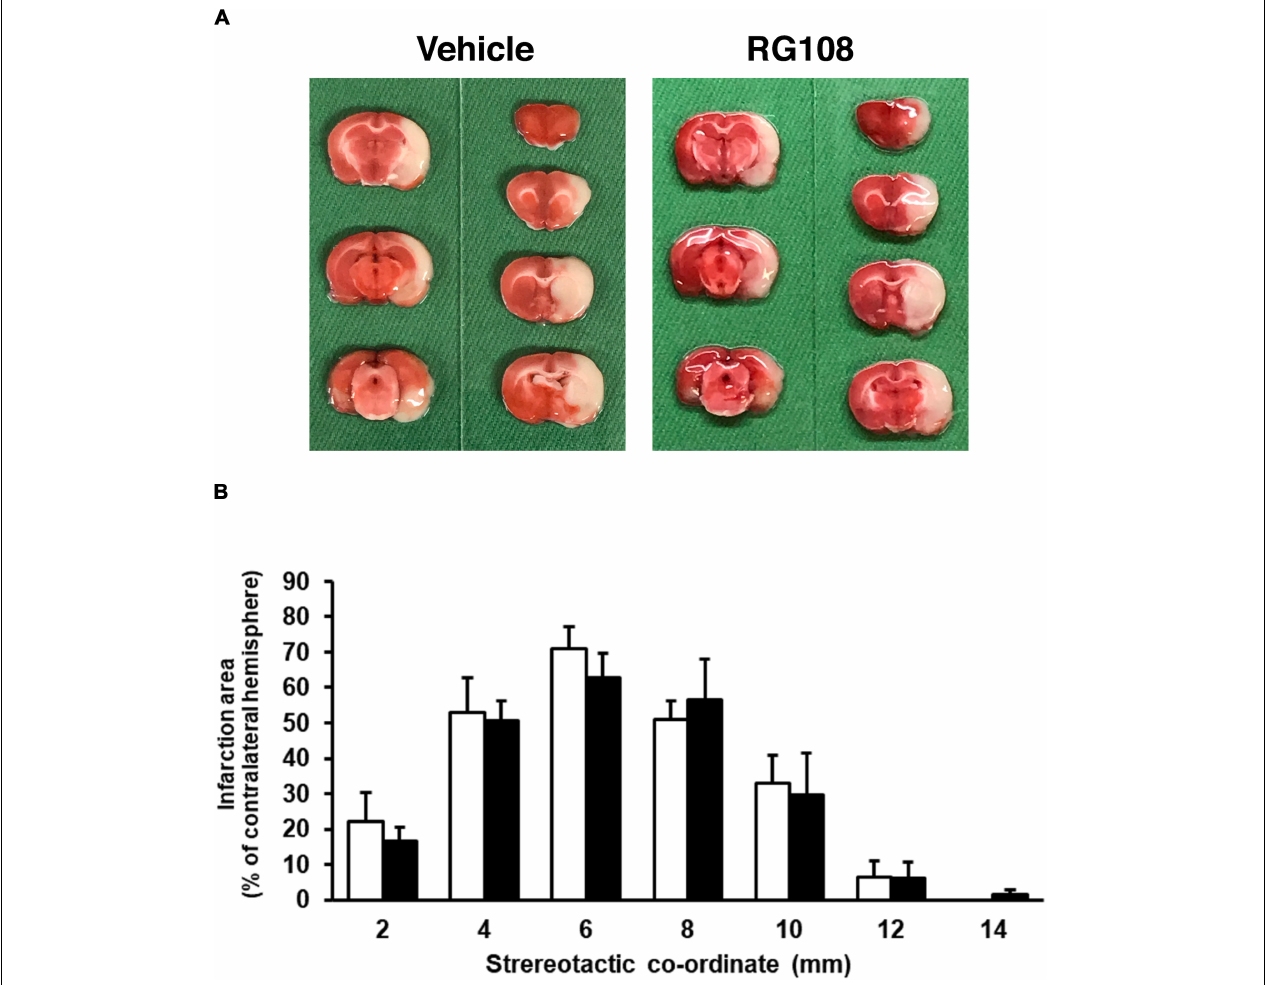
FIGURE 7 | (A) Representative photographs of TTC staining from vehicle- and RG108-treated MCAO/R rats. (B) The infarct area of hemisphere at 2, 4, 6, 8, 10, 12, and 14 mm from the forebrain in the vehicle-treated (white bars) and RG108-treated (black bars) MCAO/R rats 24 h after surgery. The infarct areas are expressed as percentages of contralateral hemisphere. Values represent the mean ± SD ( n = 4